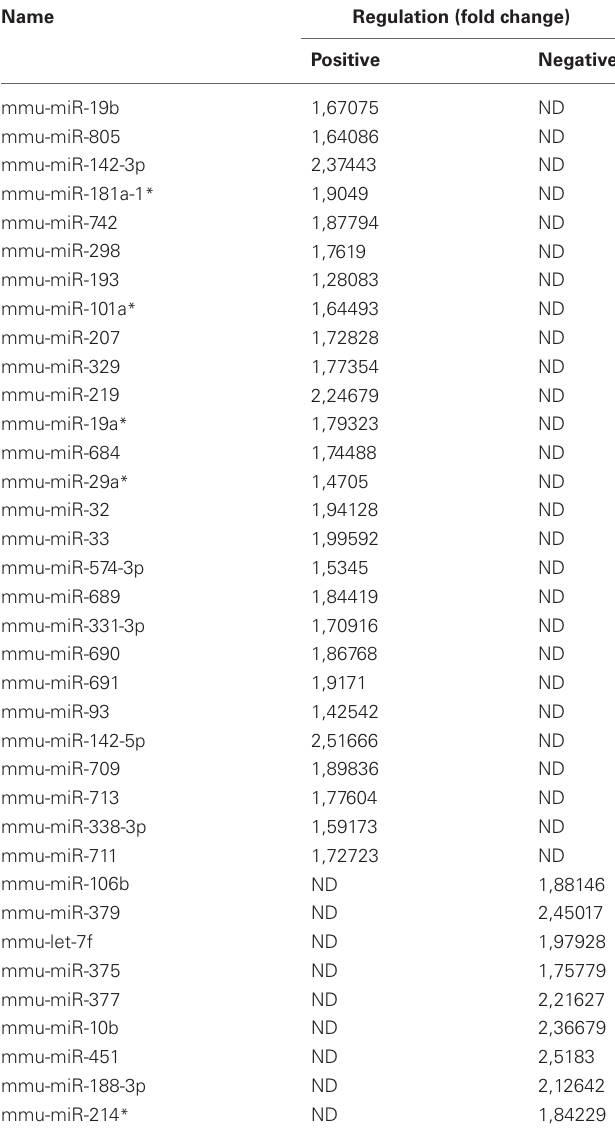
Table 1 | MicroRNA fold change